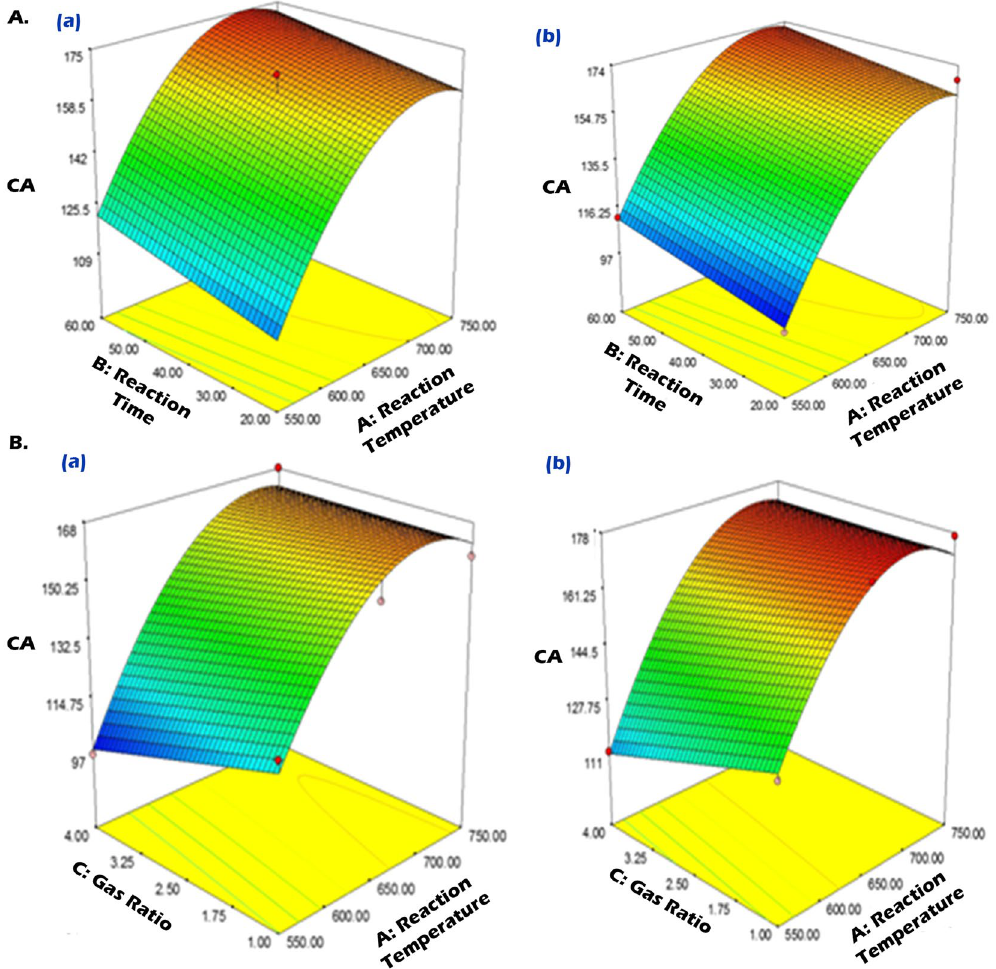
Figure 4. Response surface plots for the effects of reaction temperature and reaction time on CA at fixed gas ratio 4.0 ( Aa ) and 1 ( Ab ); and effects of reaction temperature and gas ratio on CA at fixed reaction time 60 ( Ba ) and 20 min ( Bb